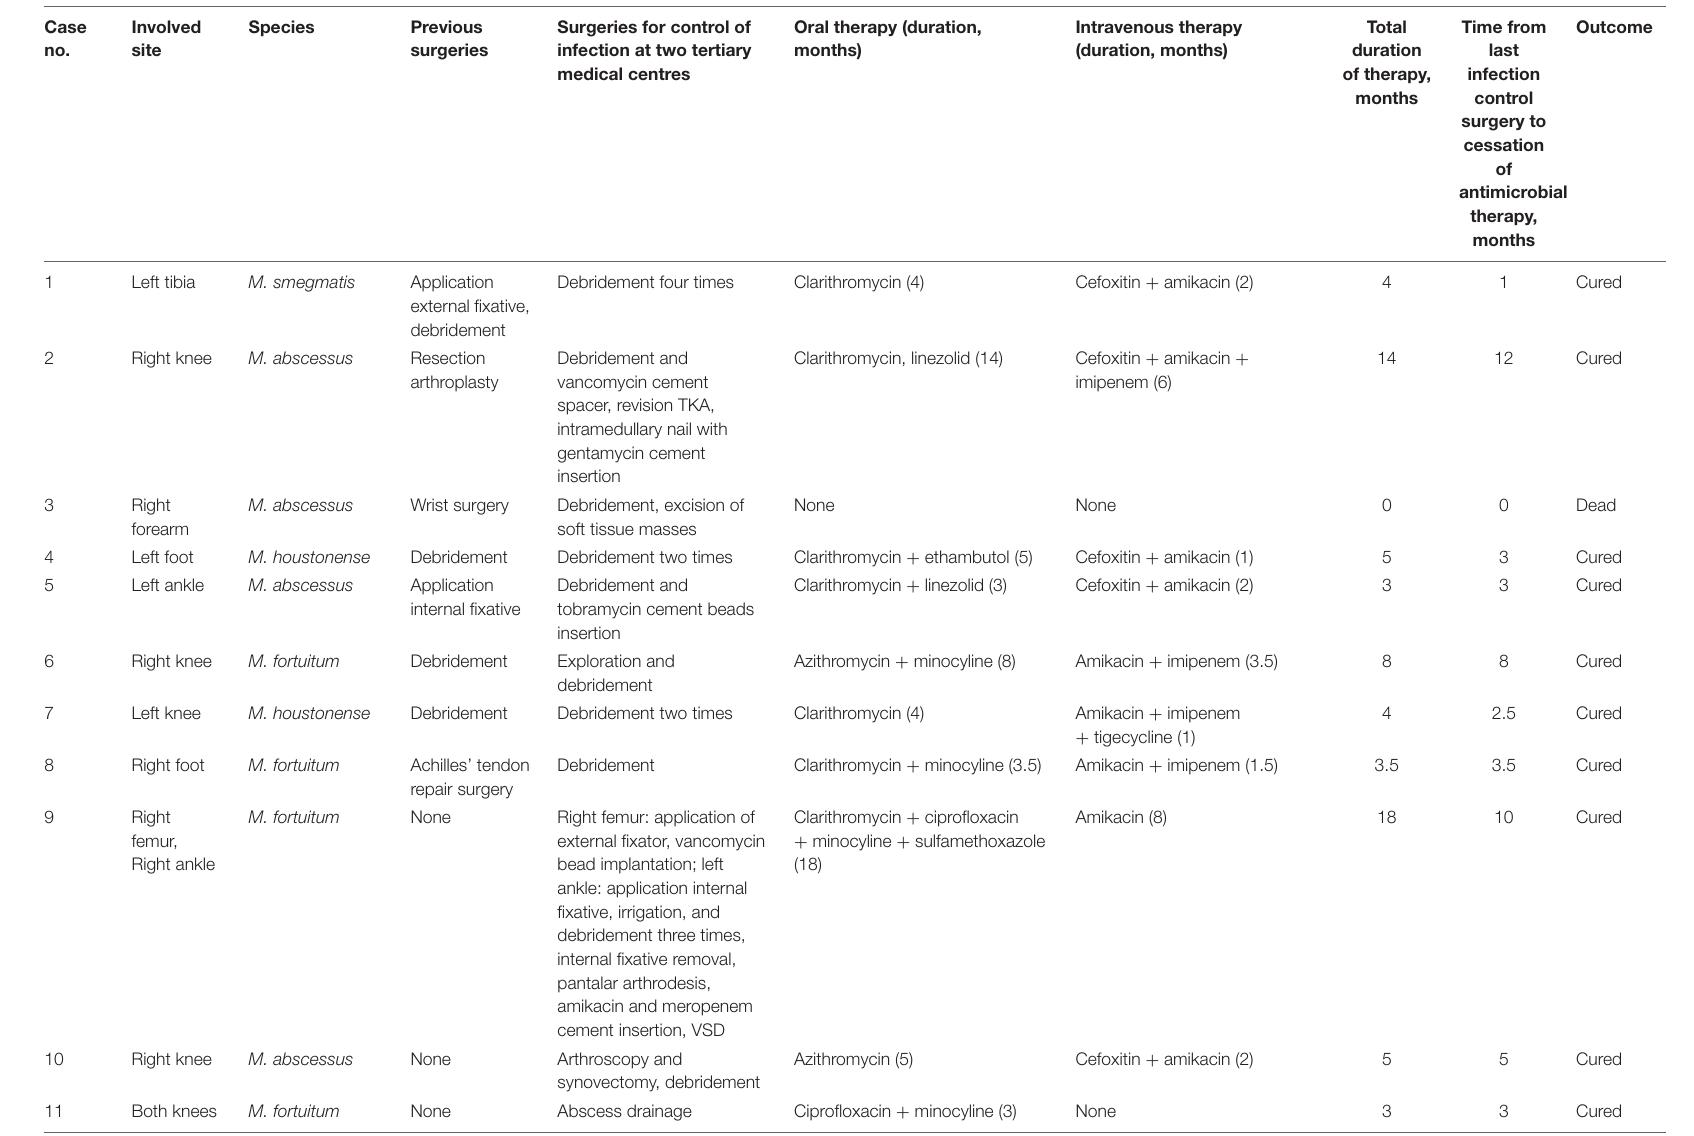
TABLE 2 | Surgical and antimicrobial treatment of 25 patients with musculoskeletal non-tuberculous mycobacterial infections, Henan, China. Case